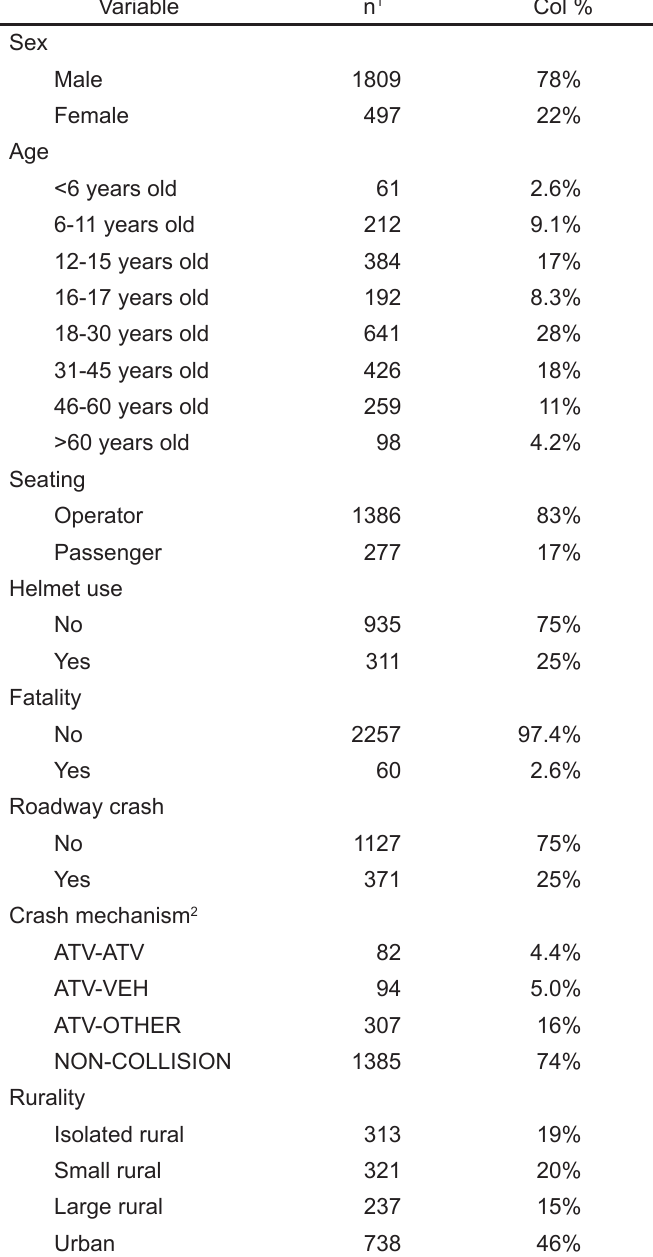
Table 1. Person and crash related characteristics for ATV crashes in the Iowa Off-Road Vehicle Crash and Injury Database from January 1, 2002 through December 31,